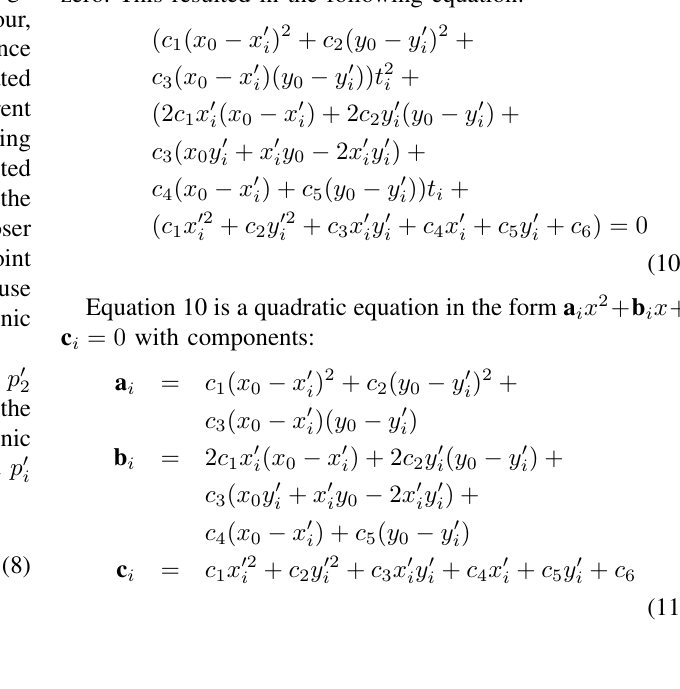
Fig. 8. (a) Standard approaches calculate the distance between p 0 and the point p ′ 0 on the contour edge. (b) In our approach, a new point position p ′′ 0 is found on the conic passing through this patch to calculate the